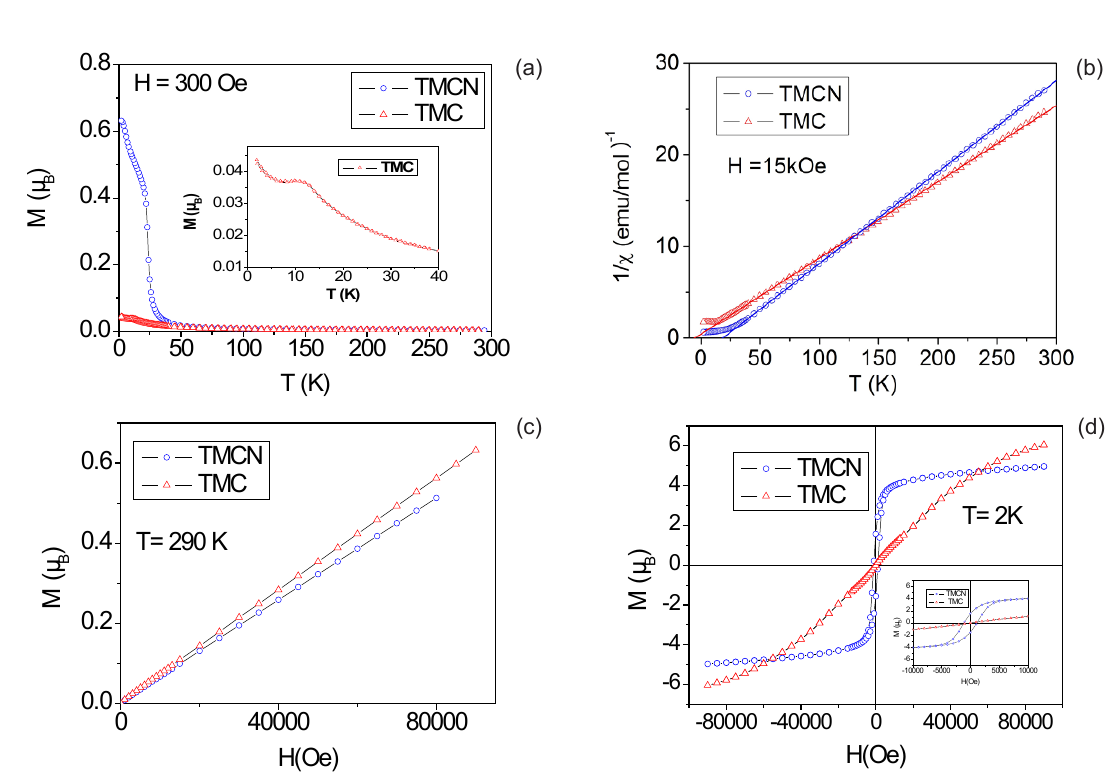
Figure 7. Comparison of (a) M(T) at 300 Oe (zoom of TMC in inset), (b) reverse susceptibility, M(H) at (c) 290 K and (d), M(H) at 2 K of TbMg (TMC) and